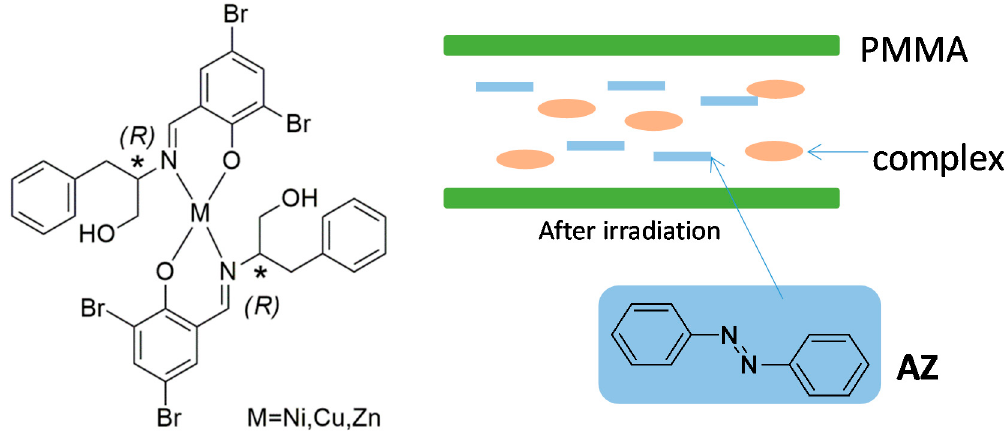
Figure 1. ( Left ) Molecular structures of Ni , Cu , and Zn ; ( Right ) Schematic representation of organic/inorganic hybrid materials M+AZ+PMMA showing anisotropic molecular orientation after linearly polarized UV light irradiation.